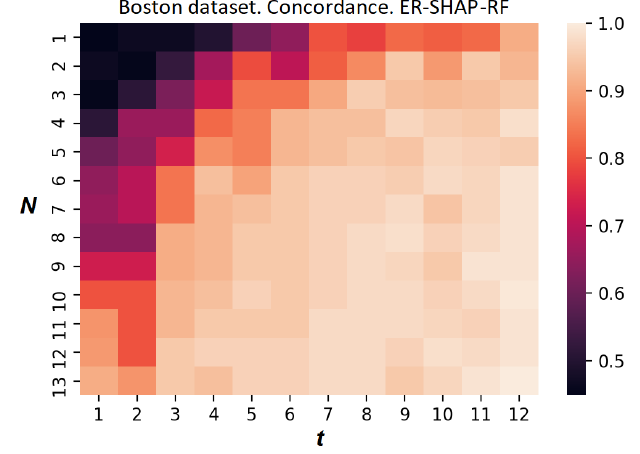
Figure 21. The heatmap reflecting the concordance index C obtained by ER-SHAP-RF for the Boston Housing dataset using the temperature scaling.